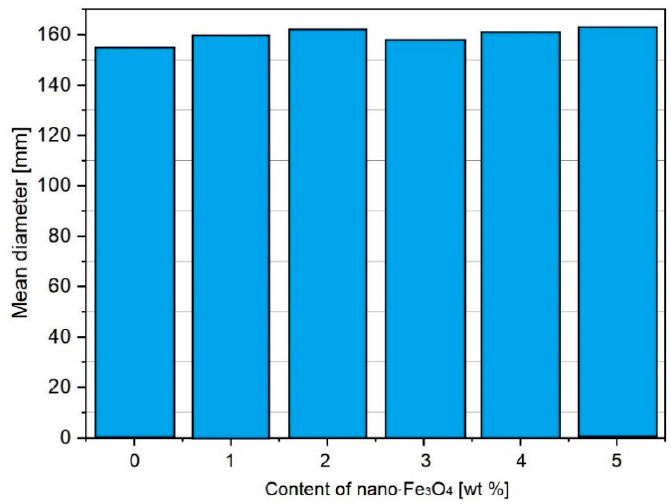
Figure 12. The consistency of the fresh mortars with nano-Fe 3 O 4 (Reprinted with permission from [40]).